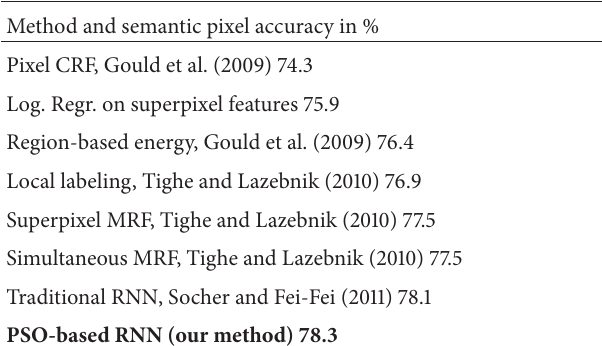
Table 1: Accuracy of pixel accuracy of state-of-the-art methods on Stanford background dataset. Method and semantic pixel accuracy in % Pixel CRF, Gould et al. (2009) 74.3 Log. Regr. on superpixel features 75.9 Region-based energy, Gould et al. (2009) 76.4 Local labeling, Tighe and Lazebnik (2010) 76.9 Superpixel MRF, Tighe and Lazebnik (2010) 77.5 Simultaneous MRF, Tighe and Lazebnik (2010) 77.5 Traditional RNN, Socher and Fei-Fei (2011) 78.1 PSO-based RNN (our method)